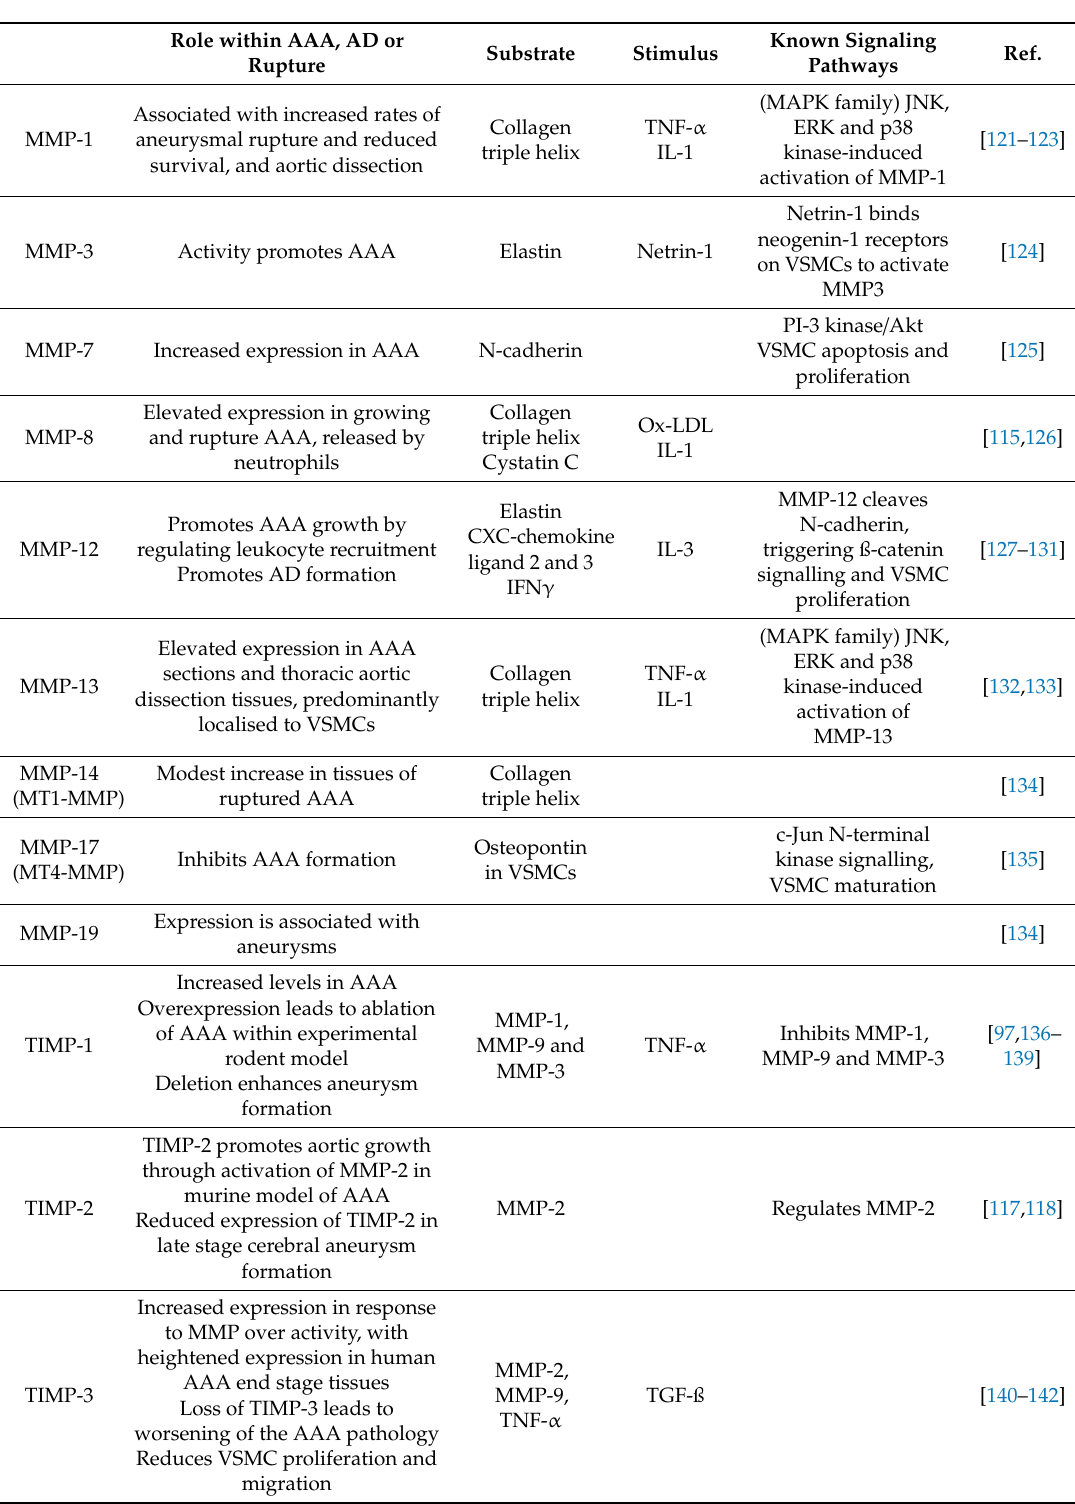
Table 1. Other MMPs or TIMPS in AAA and